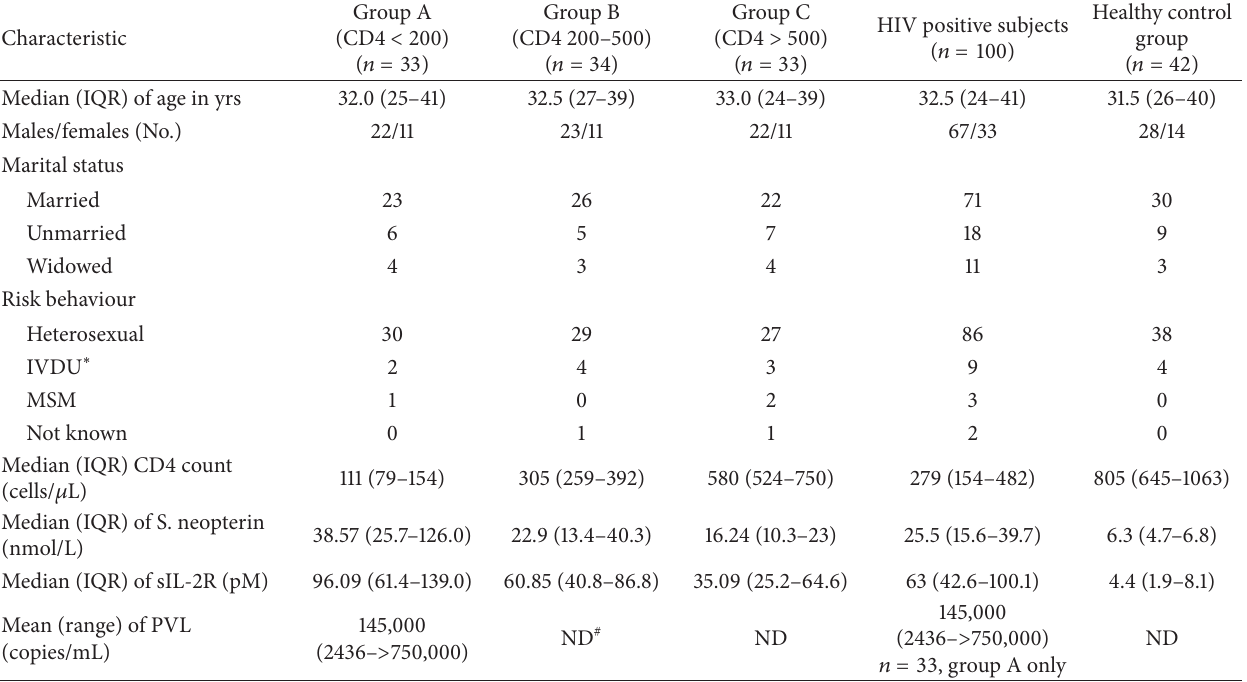
Table 1: Demographic and baseline characteristics of the study subjects.